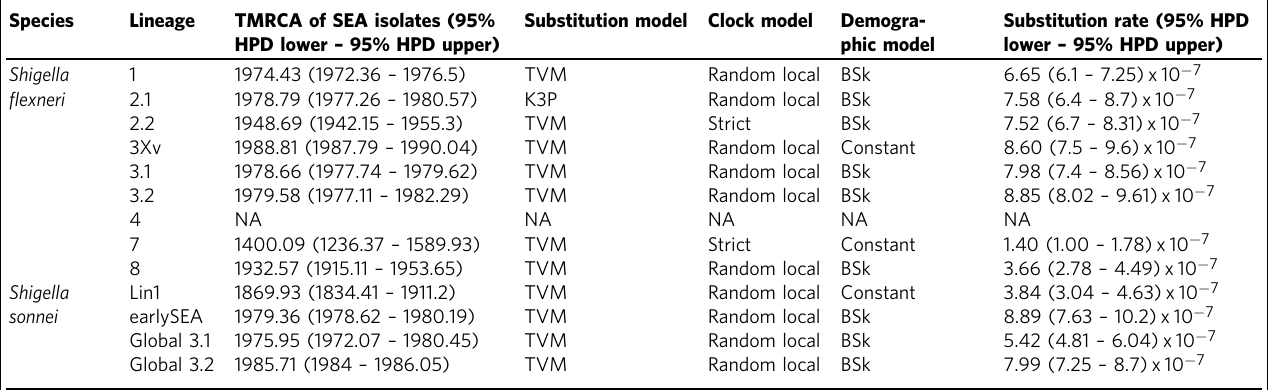
The table details the estimation of major parameters, including the estimated TMRCA (time to most recent common ancestor) of isolates in Southeast Asia and its 95% high posterior density (95% HPD), the substitution rate (in substitutions per site per year) and its 95% HPD, as well as the molecular clock and demographic models utilised. For each lineage, the results are summarised across three independent BEAST runs, and the most appropriate evolutionary models were chosen based on Bayes factor comparison. TVM Transversion model, K3P Kimura-3-parameters model, BSk Bayesian